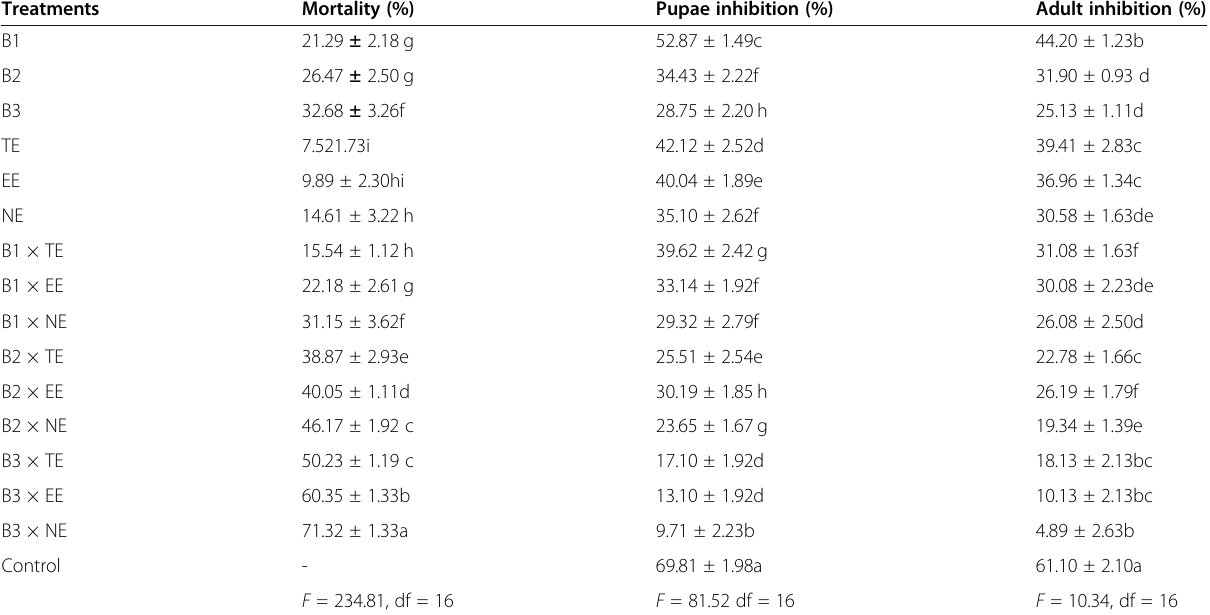
Table 1 Effect of Beauveria bassiana (Bb) and plant extracts on mortality, pupation, and adult emergence (% ± SE) of 3rd larval instars of Tribolium castaneum